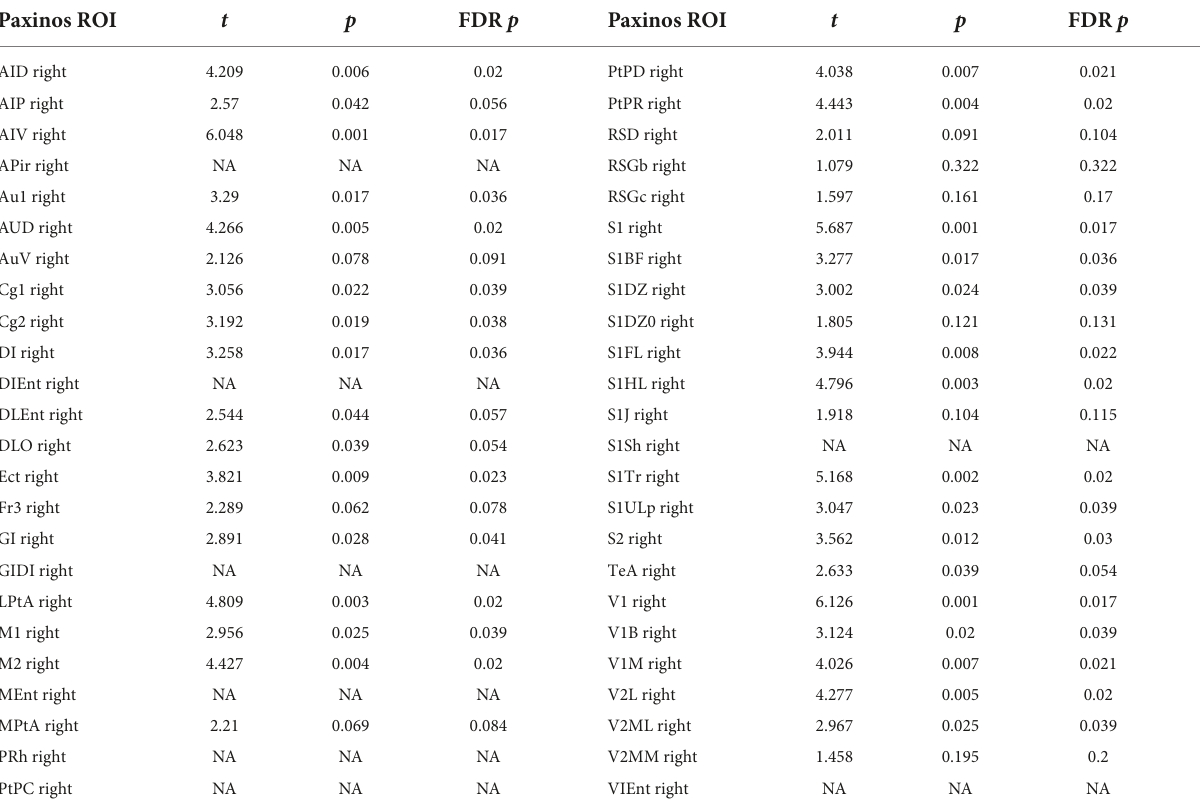
TABLE 1 TTA-P2 vs. baseline interhemispheric homotopic functional connectivity (IHFC) paired t -test for different Paxinos region of interest (ROIs). Paxinos